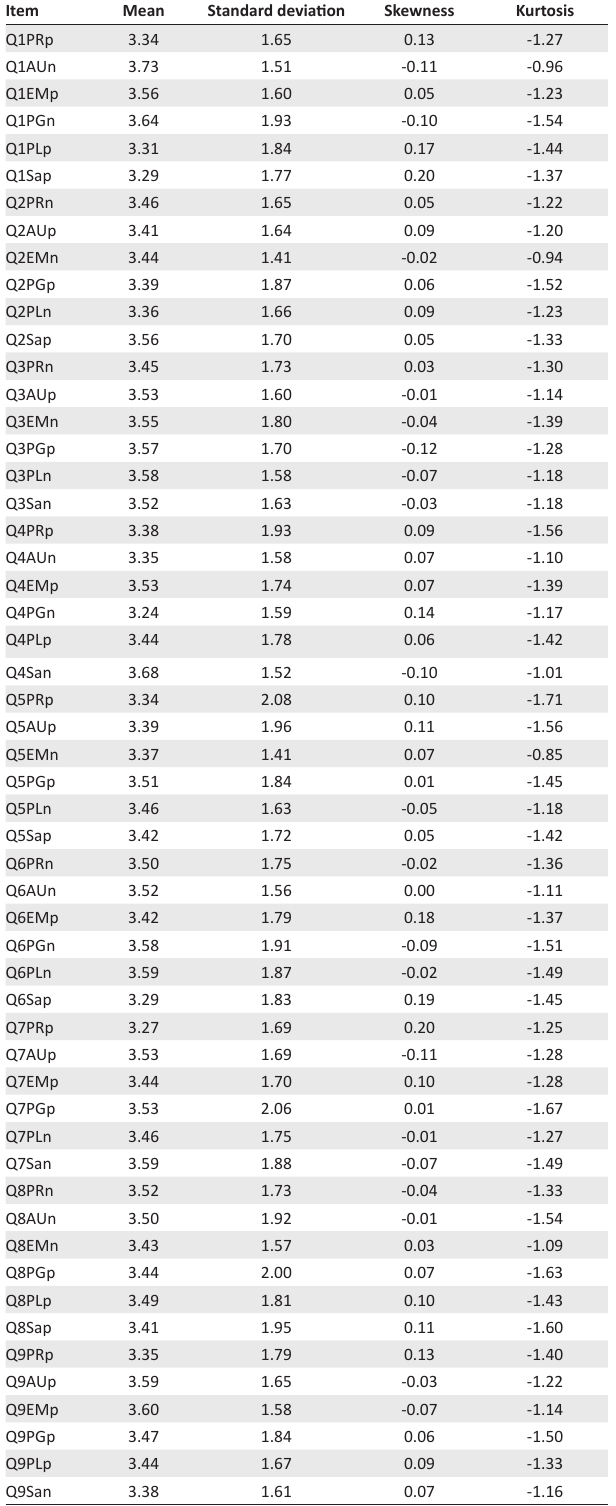
TABLE 1: Descriptive statistics for the Ryff Scales of Psychological Well-